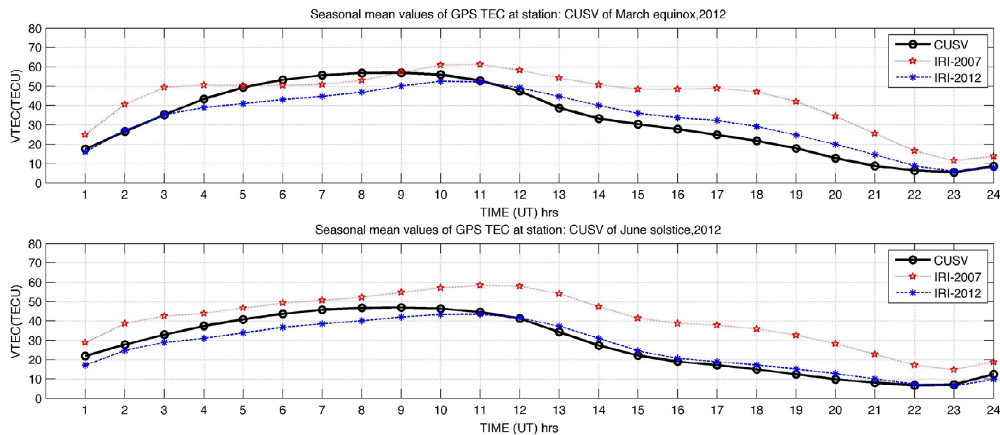
Figure 8. Seasonal mean values of GPS TEC, IRI-2007 TEC and IRI-2012 TEC at CUSV station during the period